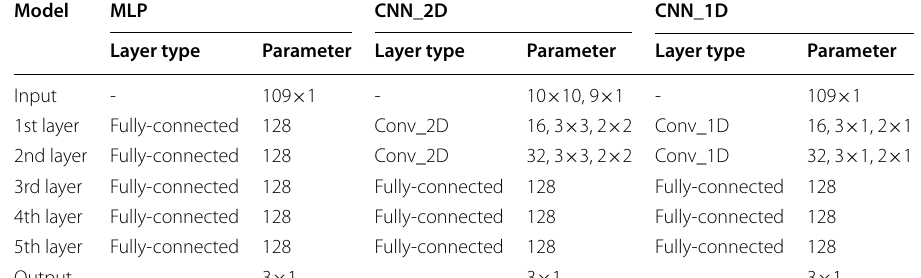
Table 6 Architectures of MLP, CNN_2D, and CNN_1D